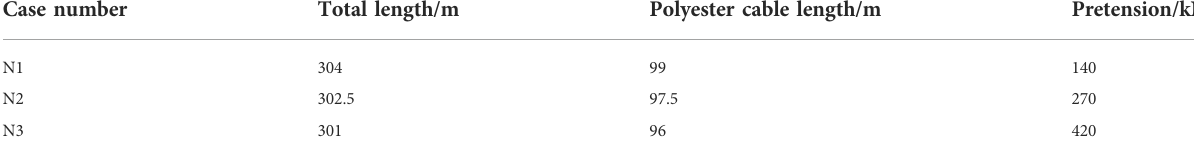
TABLE 7 Parameters of hybrid mooring